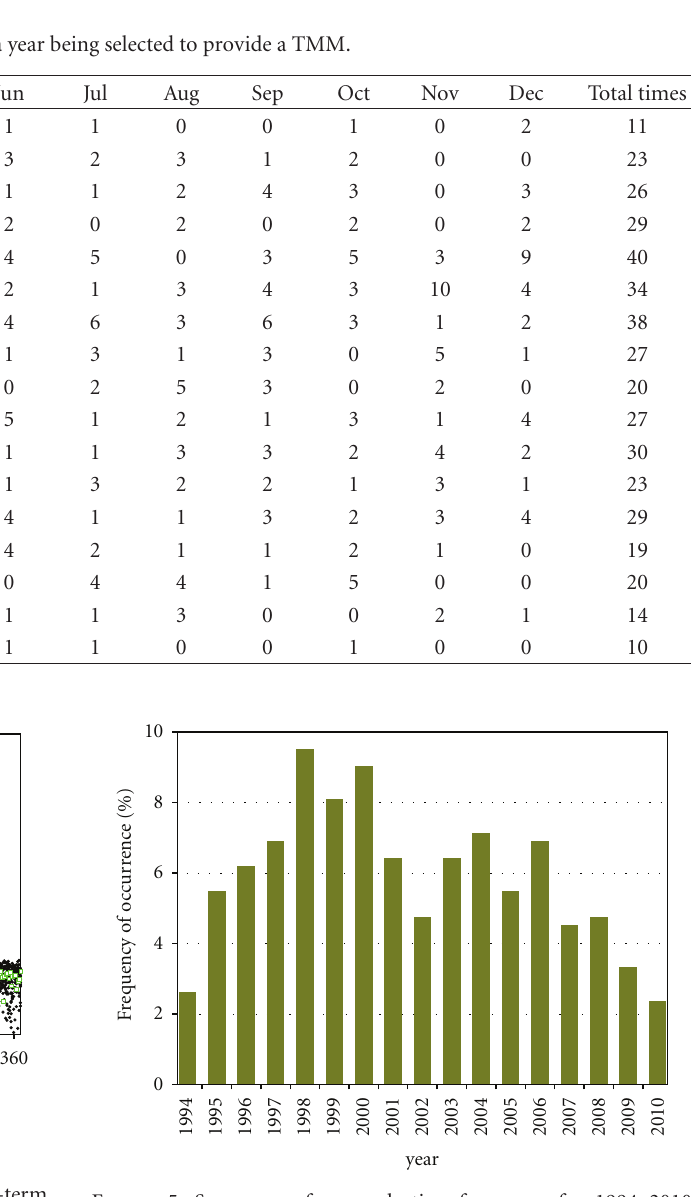
Figure 5: Summary of year selection frequency for 1994–2010